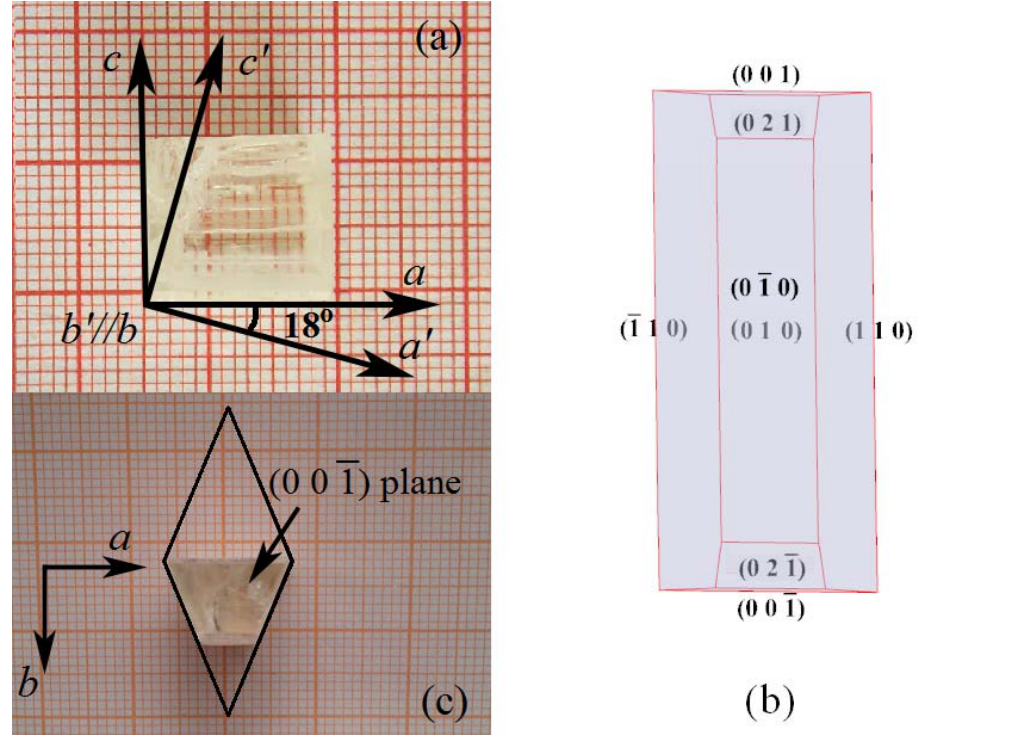
Figure 1. ( a ) Grown crystal of Tm 3+ :Li the crystal; ( c ) Cross-section of the as grown